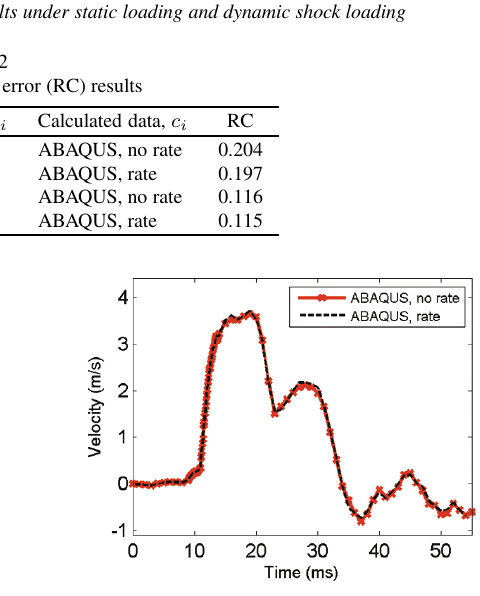
Fig. 20. Comparison between rate-independent and rate-dependent model results, dynamic shear